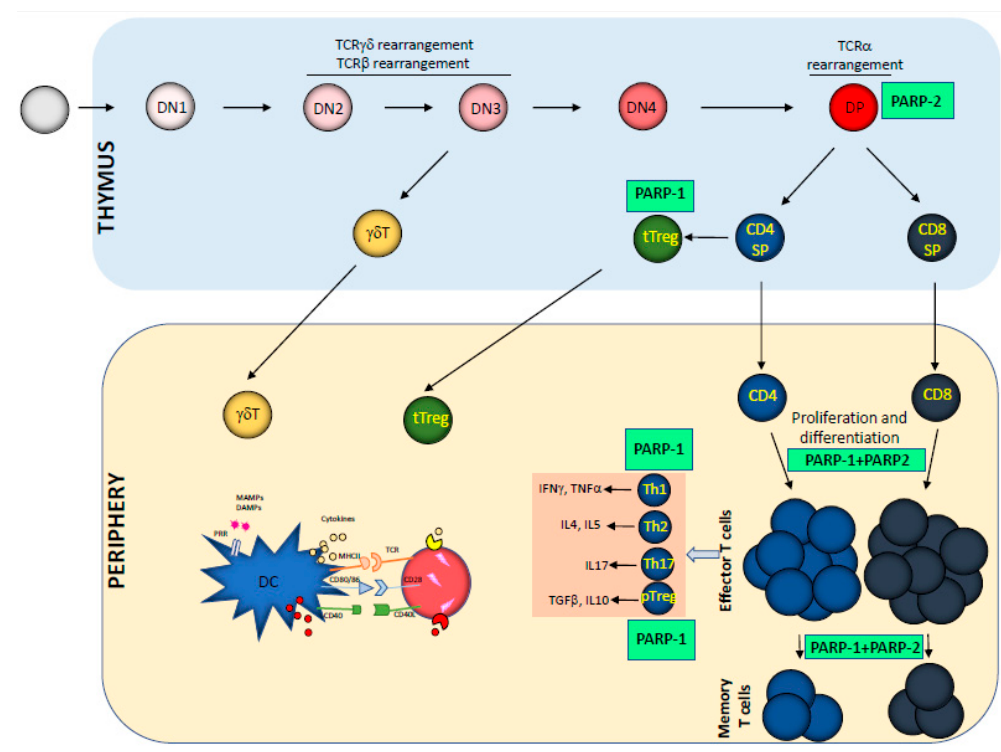
Figure 1. Schematic representation of T cell development depicting the specific stages in which PARP-1 and/or PARP-2 are playing a role. TCR, T cell receptor; DN, double negative; DP, double positive; SP, single positive; DC, dendritic cells; Treg, regulatory T cells.